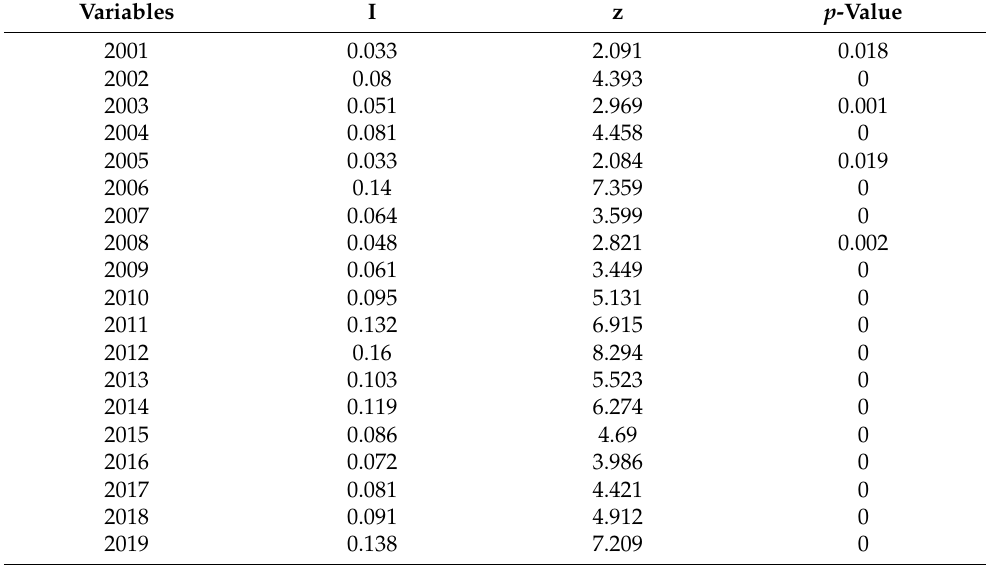
Table 4. Global Moran’s I of